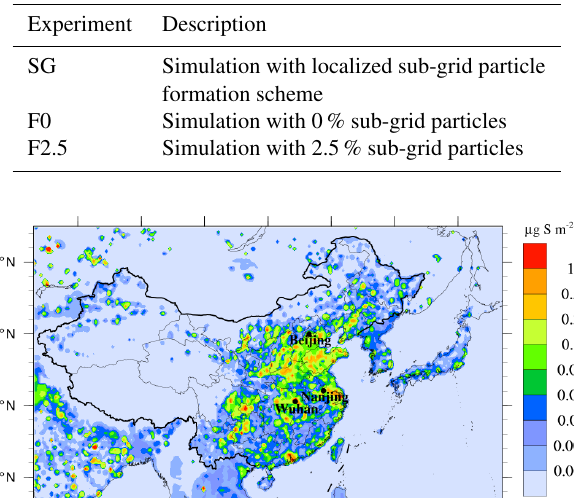
Table 1. Experiment configuration.